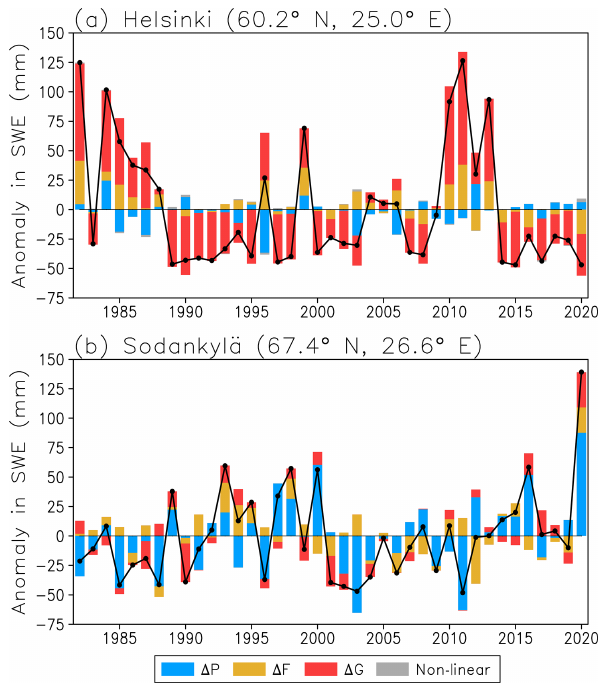
Figure 5. Anomalies of the March mean SWE in (a) Helsinki and (b) Sodankylä in the years 1982–2020 based on ERA5-Land. The solid line shows the total SWE anomaly, and the bars show the con- tributions of the four rhs terms in Eq.